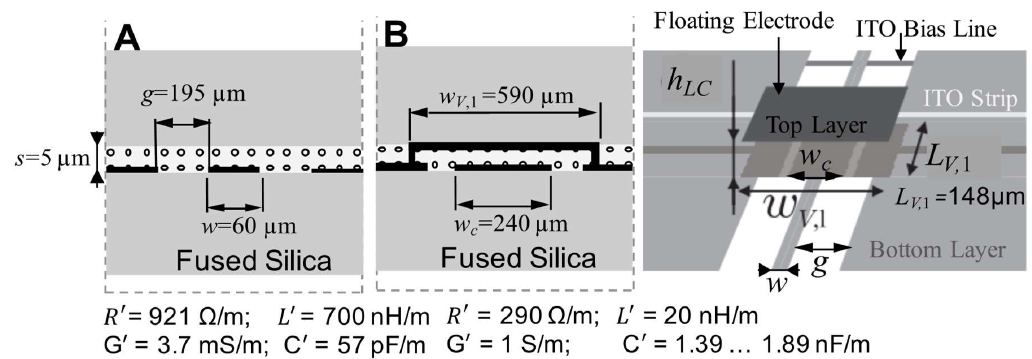
parameters of the proposed structure on the right side [185,227].